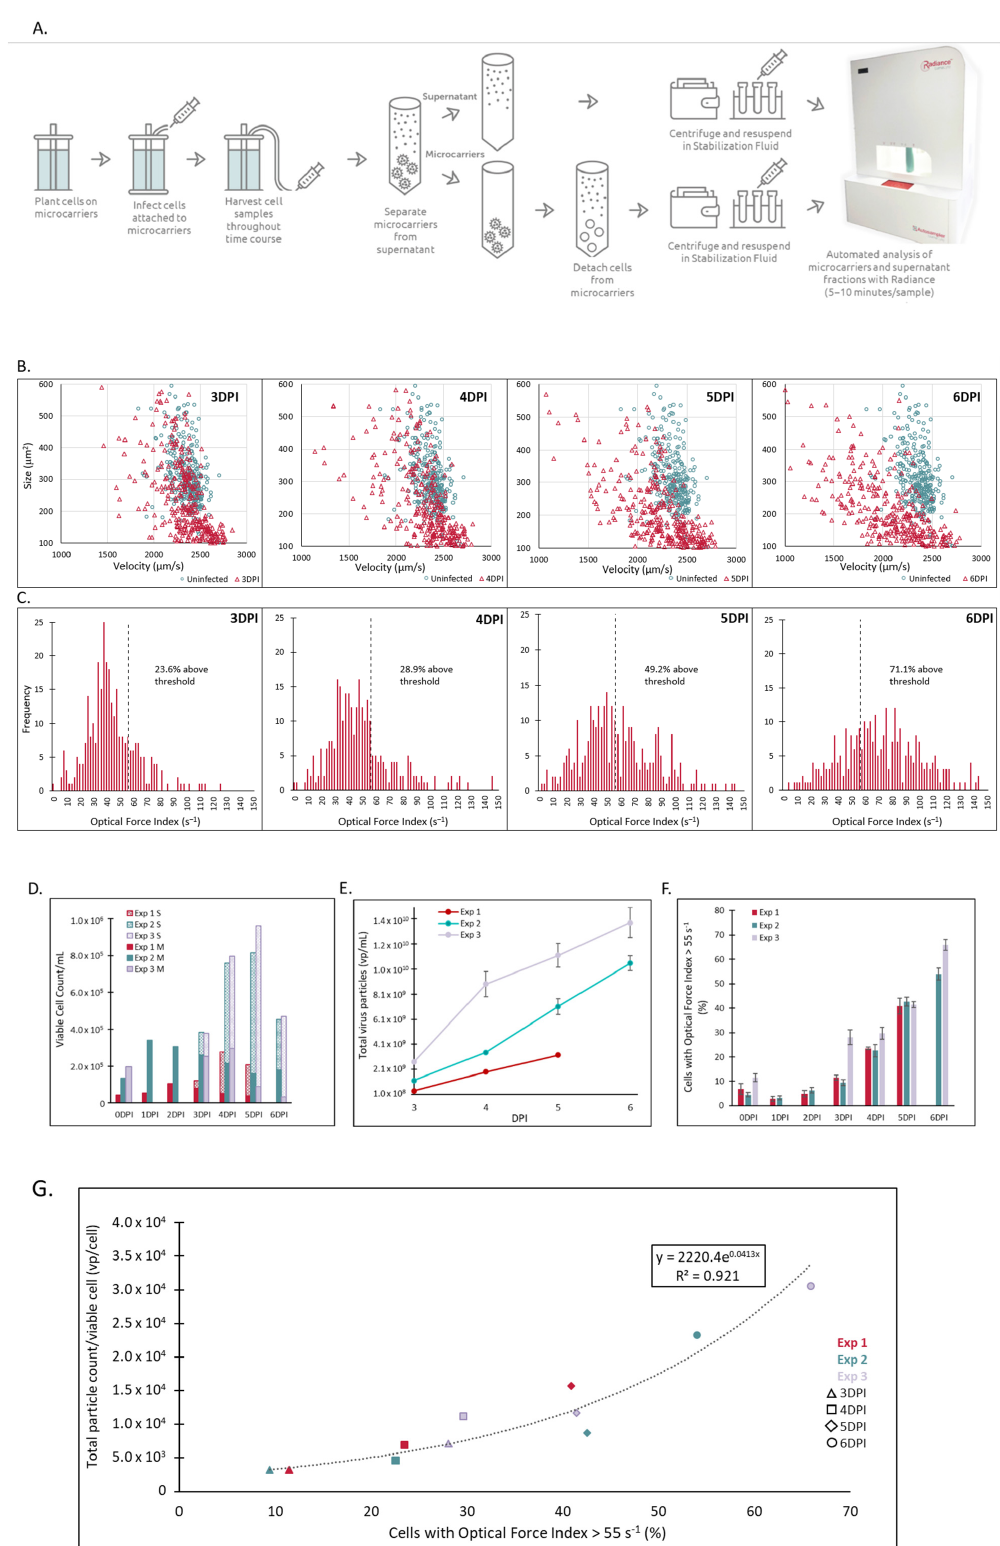
Figure 2. LumaCyte Radiance analysis of Vero cells grown on microcarriers and infected with MV at the 3 L bioreactor scale resulted in an infection metric that correlates with total particle counts. ( A ). Bioreactor and cell preparation workflow for cells grown on microcarriers in 3 L bioreactors. Cells are added to a bioreactor containing microcarriers and grown for five days before infecting with virus. Cell samples are taken throughout multiple days post-infection and separated into su- pernatant and microcarrier fractions before analyzing on LumaCyte’s Radiance instrument. ( B ). Representative scatter plots compare cell area-based size vs. velocity profiles for uninfected cells (blue) and MV infected cells (red) at 3 through 6 days post-infection (3 − 6DPI). Each dot represents a single cell analyzed by Radiance. ( C ). Representative histograms show the differences in optical